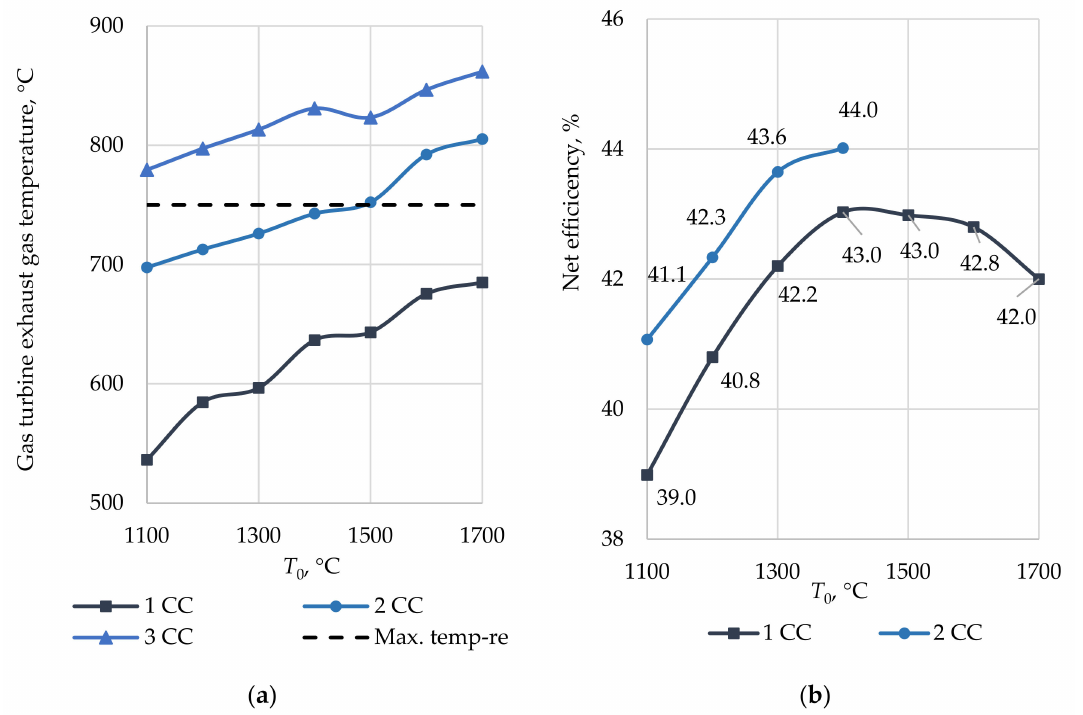
Figure 11. Optimization of the E-MATIANT cycle initial parameters, cooling losses, and regenerator limits involved: ( a ) turbine exhaust temperature; ( b ) influence of initial parameters and number of combustors on net